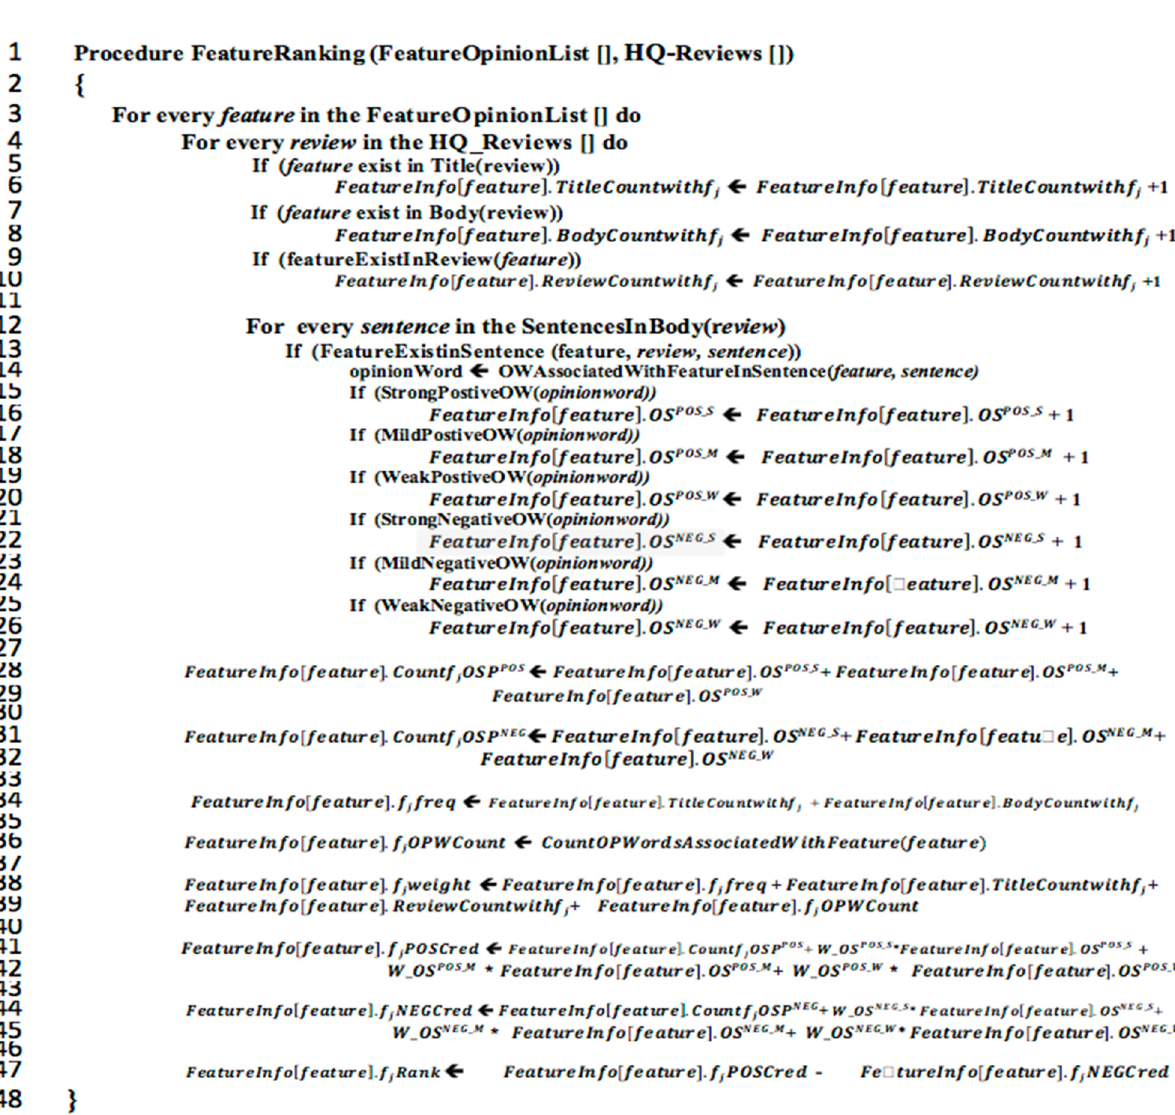
Figure 10. An algorithm for feature ranking.